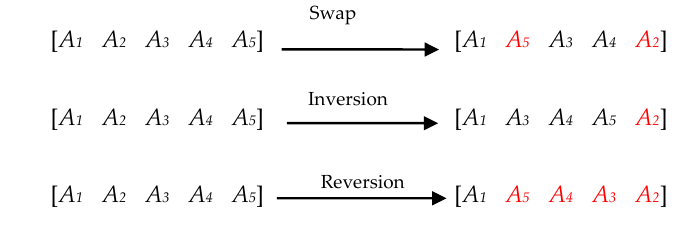
Figure 1. Additional operators in the modified FA.